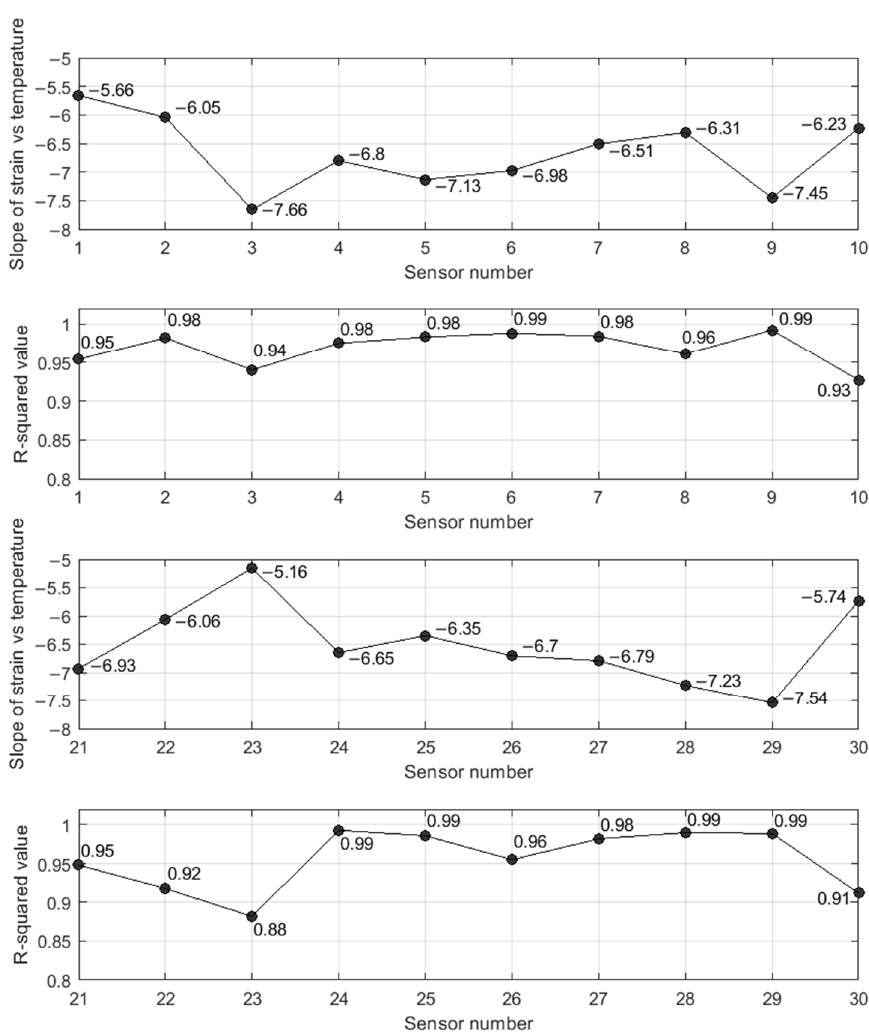
Figure 13. Slope of linear regression of the strain vs. temperature graphs (the values are expressed in µ ε /°F) and Residual R 2 of the linear interpolation strain vs. temperature. S01–S10 were bolted to the first span and S21–S30 were bolted to the second span.